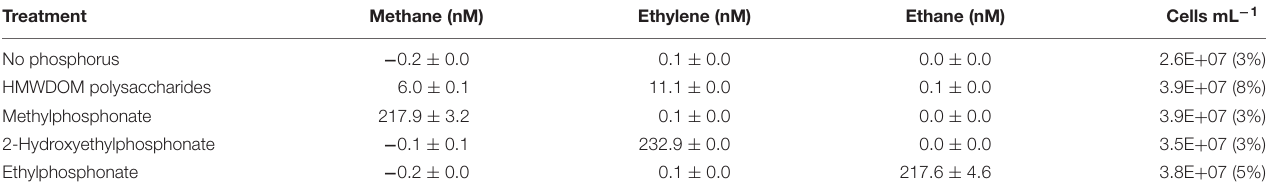
TABLE 1 | Hydrocarbon gas production and cell yields of Sulfitobacter sp. HI0054 cultures amended with HMWDOM polysaccharides or phosphonates.